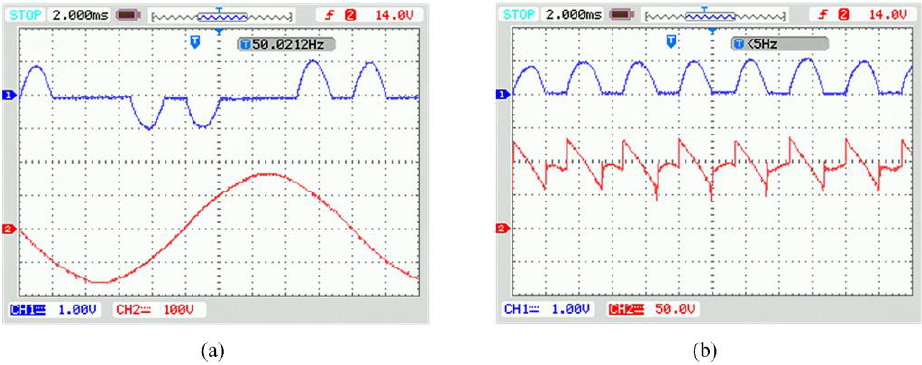
Figure 10. Exemplary results; the firing angle equal to 60°; motor idling speed; ( a ) input current and input line-to-line voltage waveforms; ( b ) motor current and motor supply voltage waveforms.